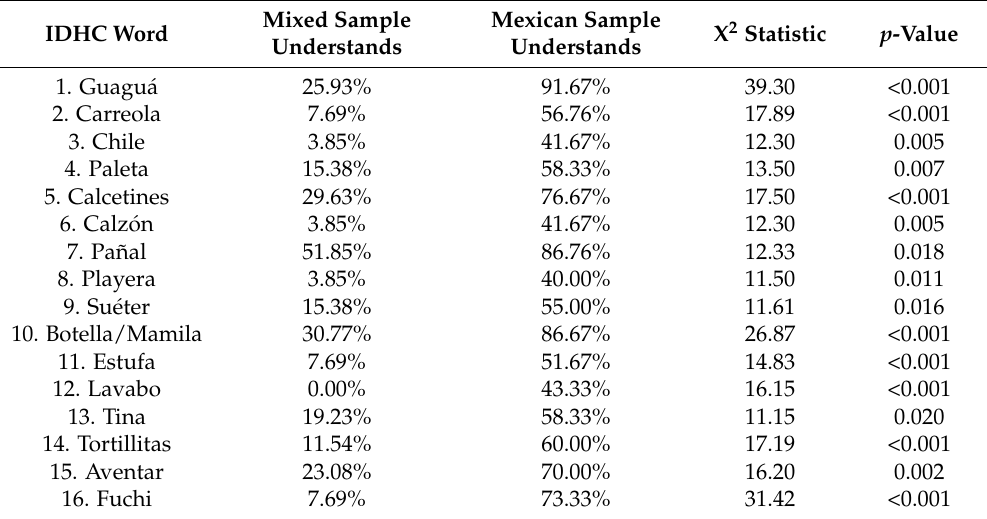
Table 3. Reported comprehension differs between samples for a subset of the MacArthur